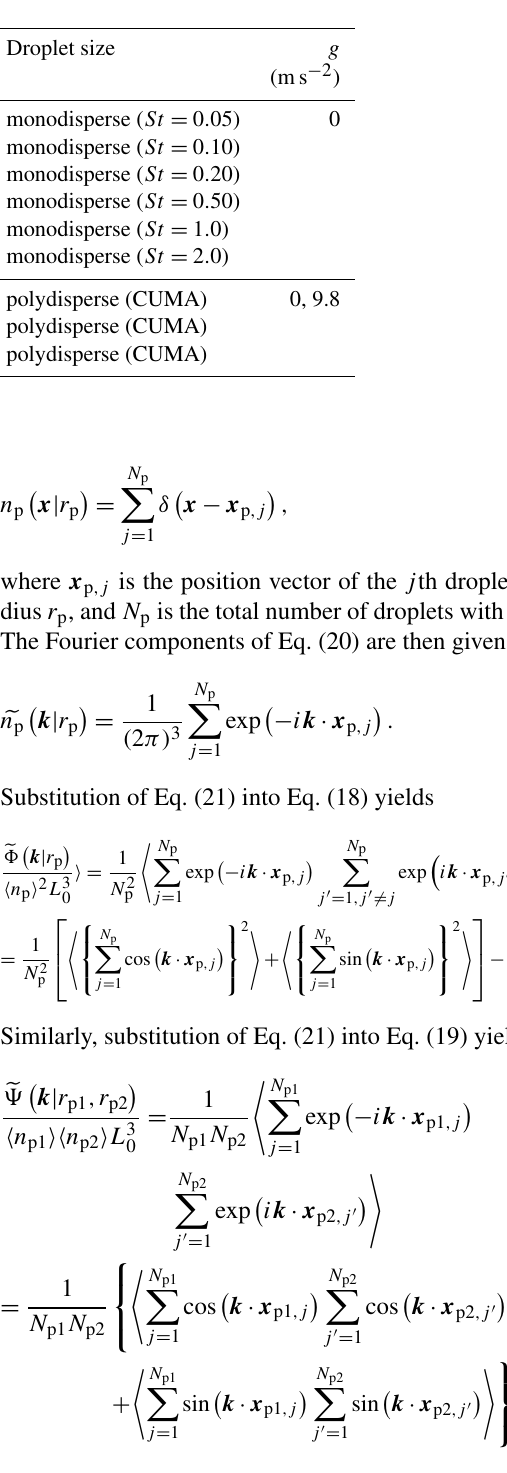
Table 1. Computational settings of the